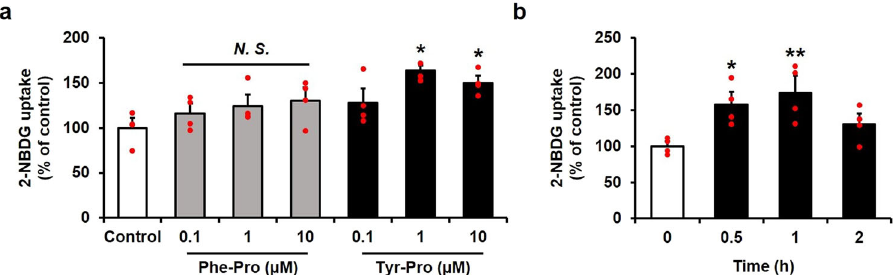
Fig. 2 2-NBDG uptake by dipeptides in L6 myotubes. a The effect of Phe-Pro or Tyr-Pro concentrations on 2-NBDG uptake. L6 myotubes were incubated with 0.1, 1, or 10 µM dipeptides for 0.5 h. b The effect of incubation time with 1 µM Tyr-Pro on 2-NBDG uptake. L6 myotubes